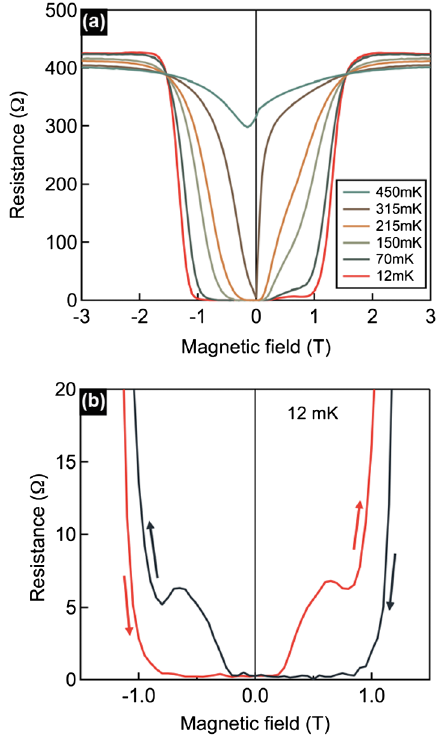
FIG. 4. (a) Magnetoresistance of a La-doped SrTiO 3 film with a carrier density of 1 (cid:2) 10 20 cm (cid:1) 3 as a function of temperature, measured with increasing B field. (b) Magnified magnetoresis- tance at 12 mK. The hysteresis in sweeps with increasing and decreasing B (see arrows) indicates the coexistence of super- conductivity and